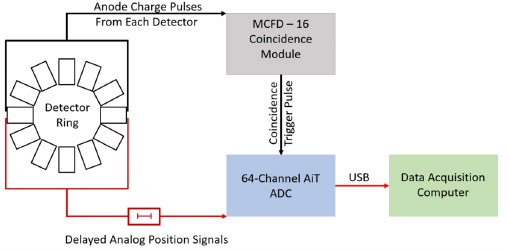
Figure 3. Schematic of the BRPET systems data acquisition system.